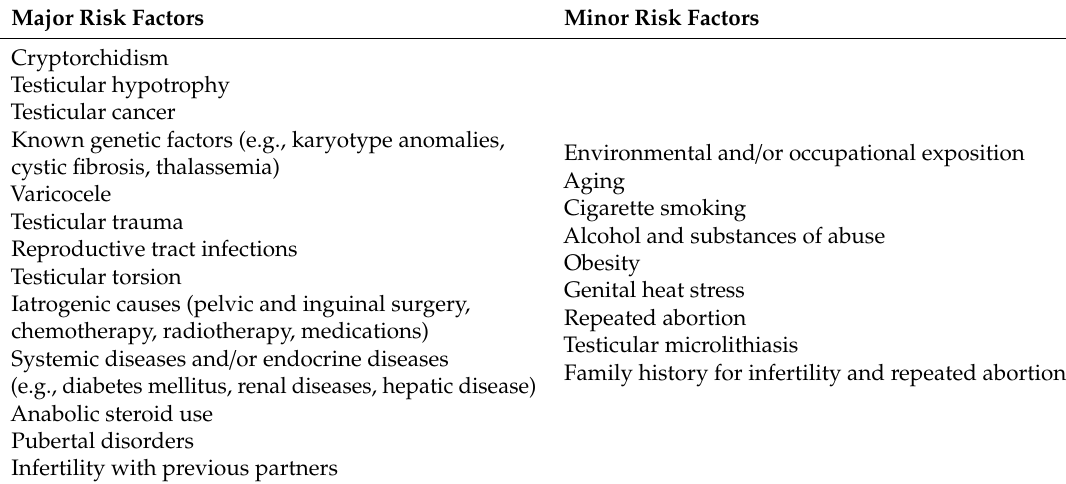
Table 1. Risk factors for infertility that should prompt for a full examination irrespective of the duration of infertility. Major risk factors are those for which the evidence and literature is strong in supporting a role for male infertility and they have a profound e ff ect. Minor risk factors are those for which evidence is weaker or the impact on male infertility is not obligate.